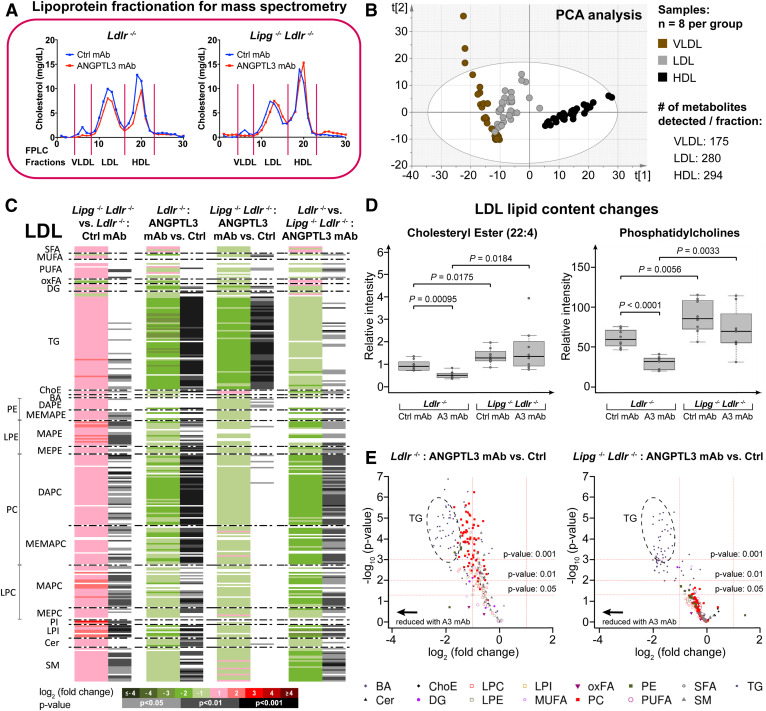
Lipidomic analysis reveals the impact of EL on LDL composition. A: Sample preparation for lipidomic analysis. Serum of chow-fed Ldlr−/− and Lipg−/−Ldlr−/− individual mice was collected 7 days after mAb administration and subjected to FPLC analysis to separate lipoproteins. Fractions corresponding to VLDL/LDL/HDL were pooled and snap-frozen for subsequent metabolite extraction. B: Score scatter plot (unsupervised PCA) showing clustering of lipidomics samples depending on lipoprotein species. Model diagnostics: A = 6; R2X = 0.872; Q2X = 0.813. C: Heatmap representing individual metabolites (denoted on the left side) obtained for the comparisons performed in LDL samples (n = 8 mice per group). Heatmap color codes for log2 (fold-change) and unpaired two-tailed Student’s t-test P-values are indicated at the bottom. D: Boxplots (defined in the Materials and Methods) of LDL-lipids upon ANGPTL3 mAb or isotype control. P-values are from unpaired two-tailed Student’s t-test. E: Volcano plots showing impact of ANGPTL3 inhibition on LDL in Ldlr−/− and Lipg−/−Ldlr−/− mice. All mice were on chow diet. See also lipidomics data in supplemental Table S3.